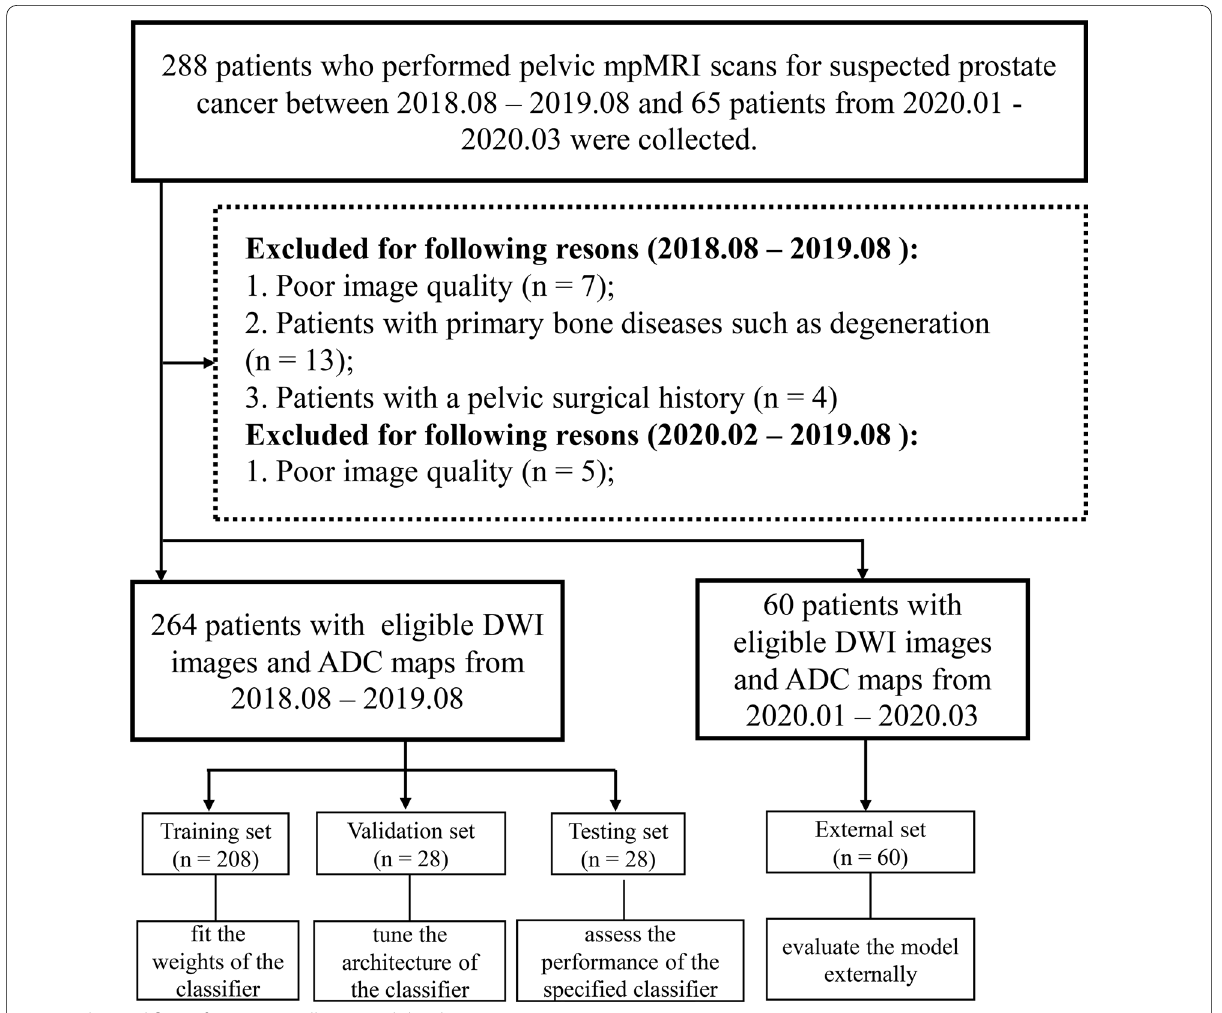
Fig. 1 The workflow of patient enrollment and